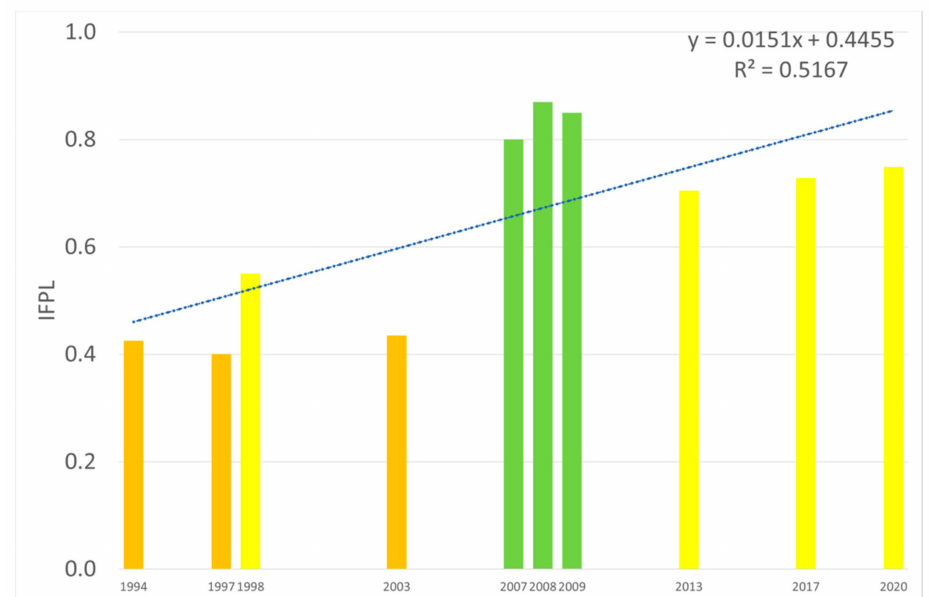
Figure 5. Changes in IFPL values and the trend line in the Vistula in the period from 1994 to 2020 (orange—poor, yellow—moderate, green—good ecological